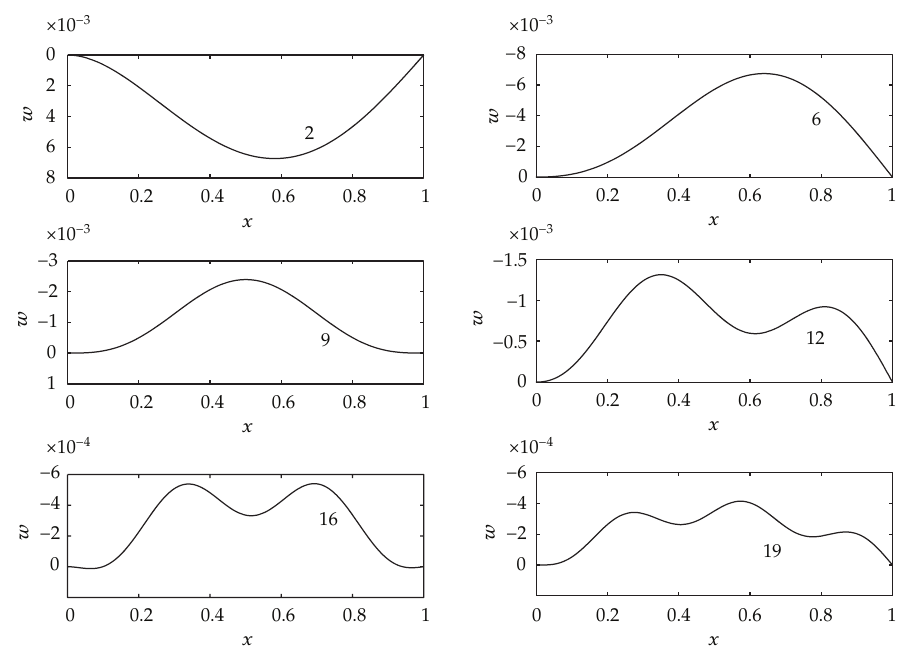
Figure 14: Graphs of the displacement for representative values of the beam number B in the intervals I 1 to I 6